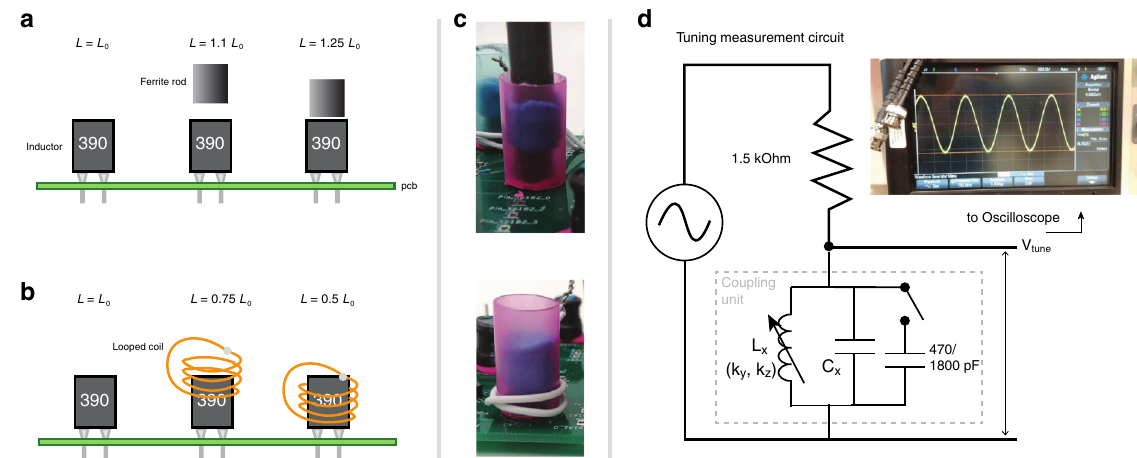
Fig. 9 Tuning of variable inductors. Illustration of tuning methods of the variable inductors and circuit diagram of impedance measurement circuit for tuning inductors and imaging the drumhead region. a By adding a ferrite rod to the top of a fi xed-value inductor, the inductance may be increased by up to 25%. b By surrounding the inductor with a shorted wire loop, the inductance may be decreased by up to 50%. c Experimental implementation of ferrite rod and wire loop. A plastic straw and modeling clay is used to hold the ferrite rod/wire loop in place after tuning. d External circuit used to measure and tune the impedance of each coupling unit (logical component), as described by (19).